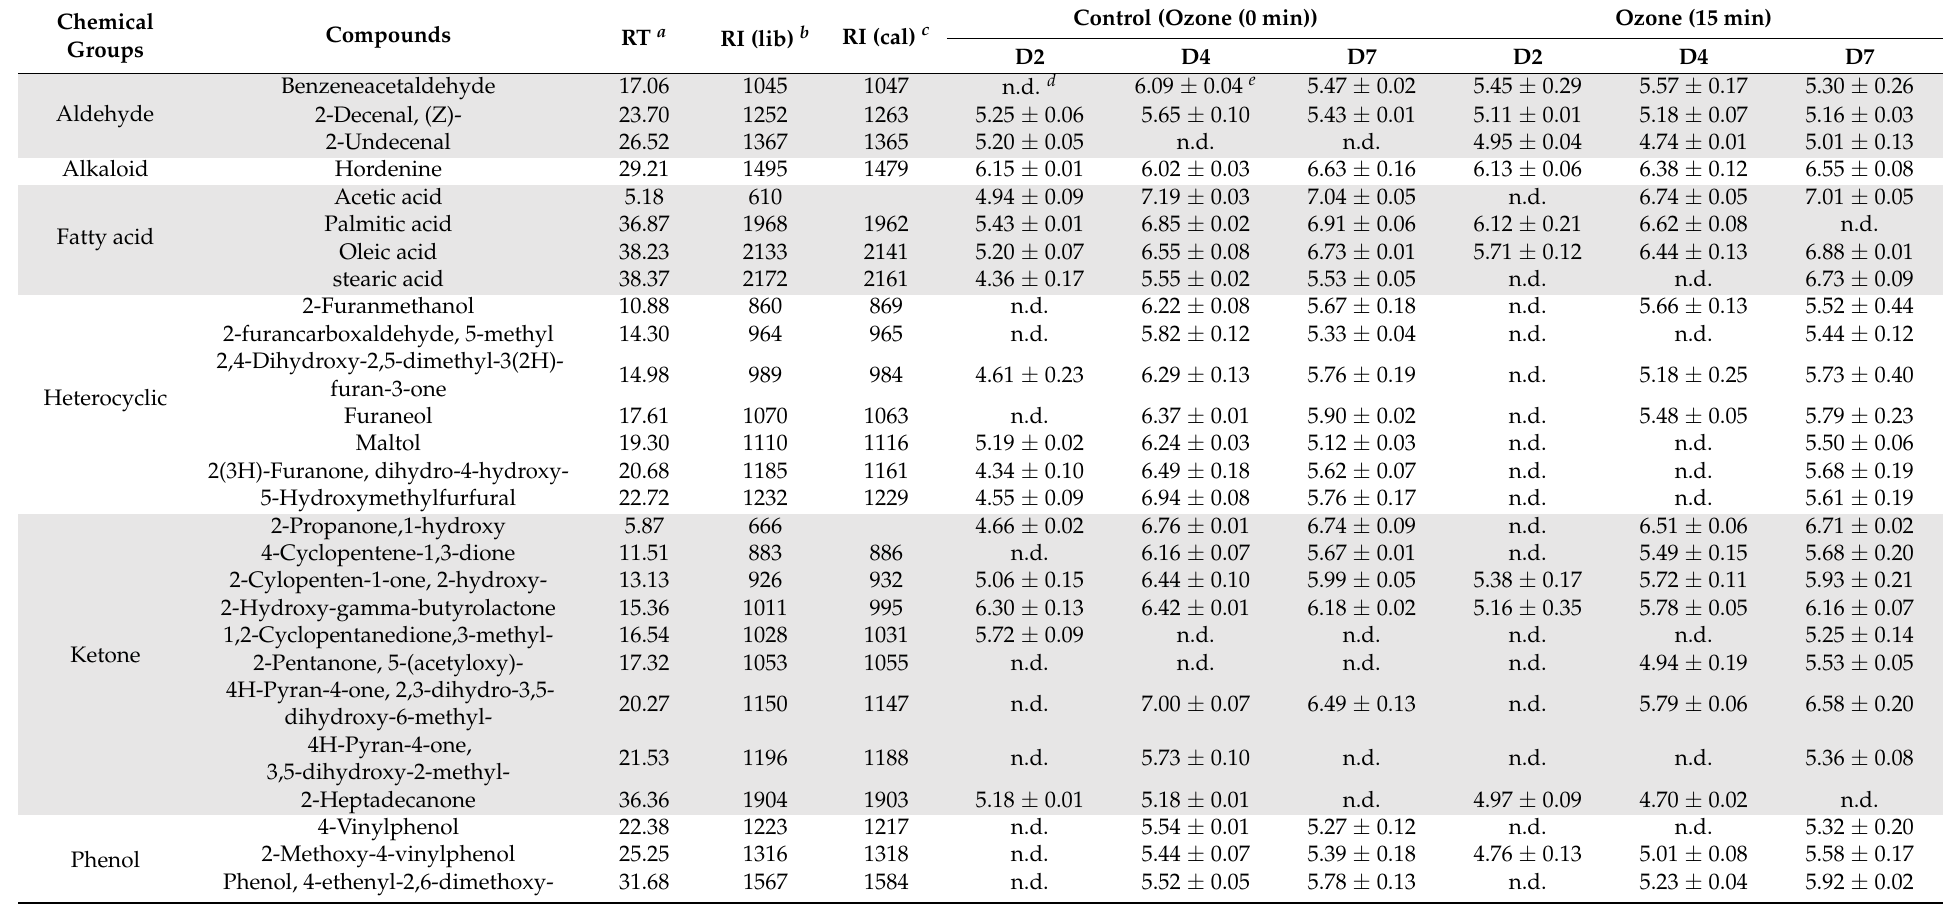
Table 2. Analysis of volatile compounds of germinating barley seeds (Scope CL) under different ozone treatment times by liquid absorption. Chemical